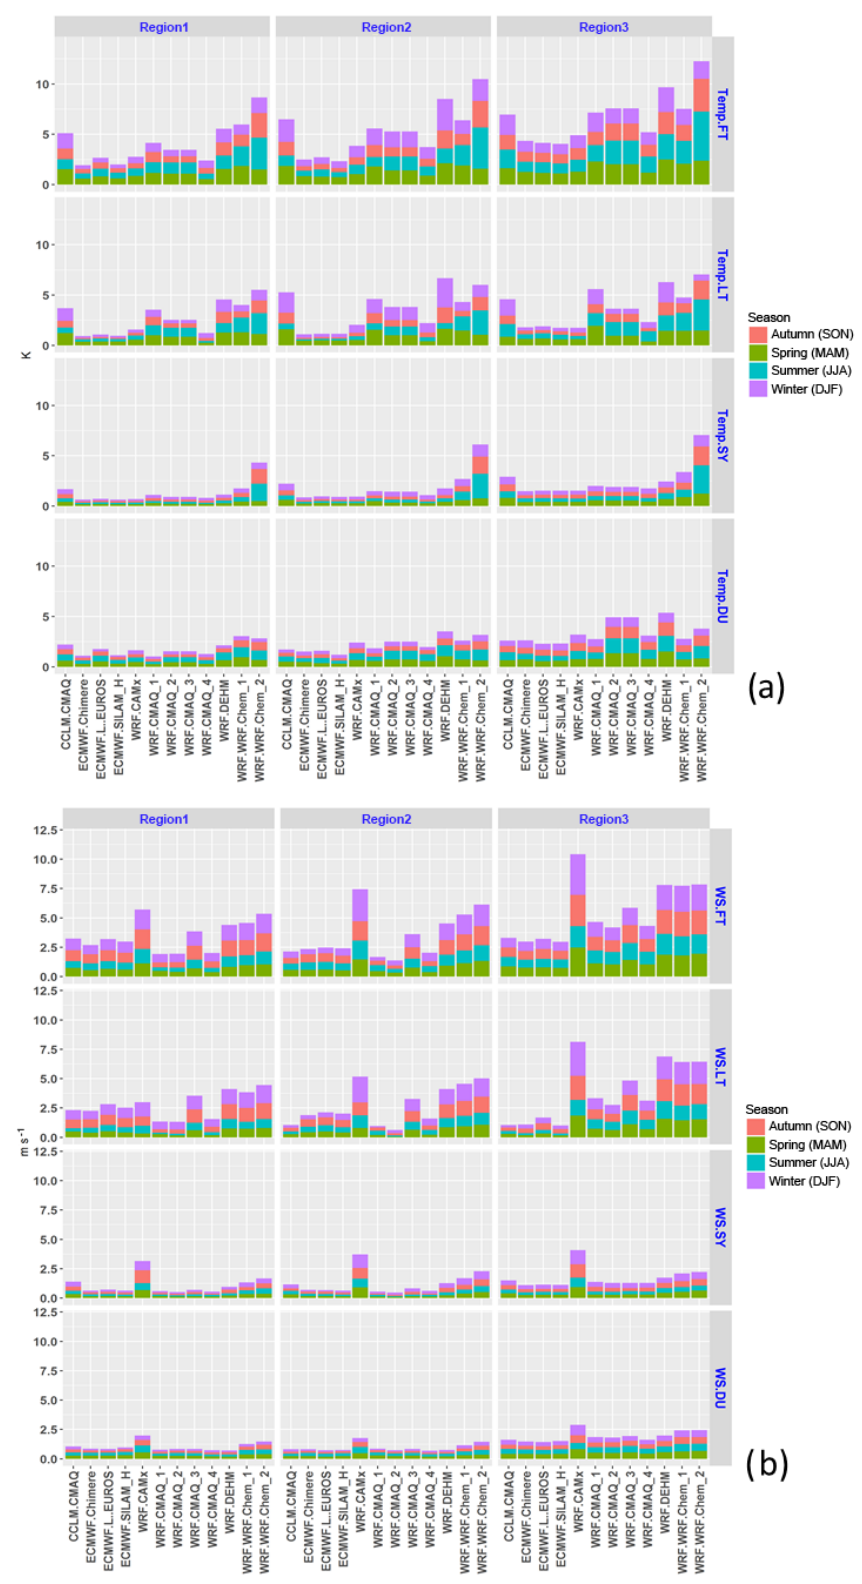
Figure 2. RMSE for (a) temperature and (b) WS in